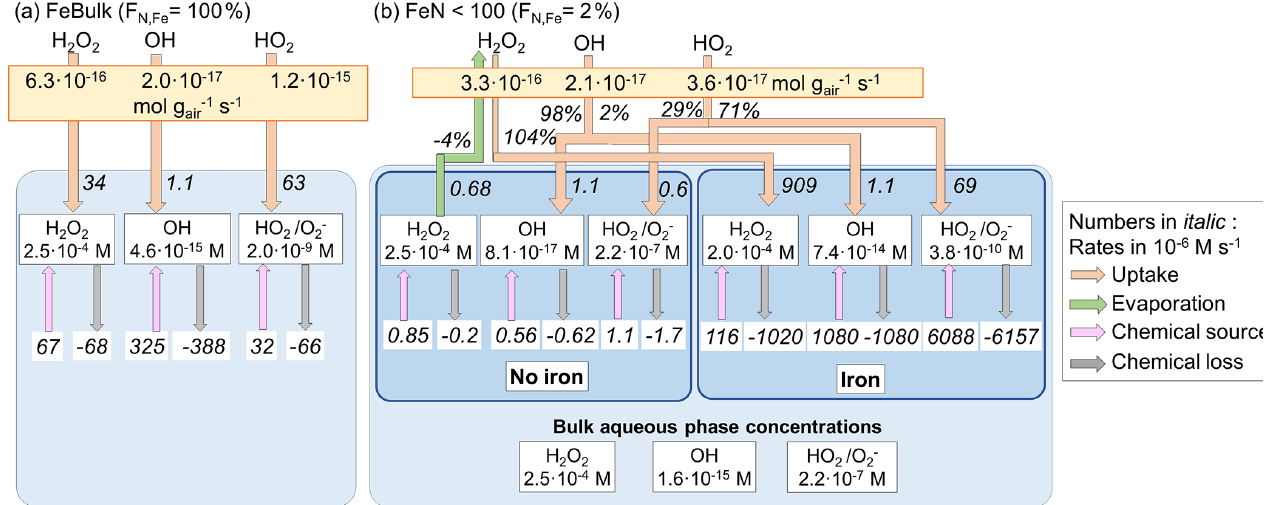
Figure 3. Same as Fig. 2 but for the aerosol case (model parameters in Table